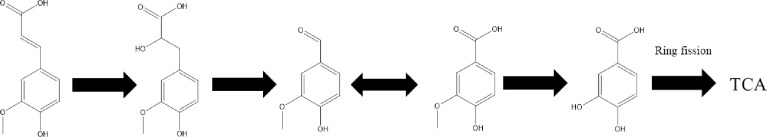
Speculated biodegradation pathways of ferulic acid and vanillic acid by marine bacteria.